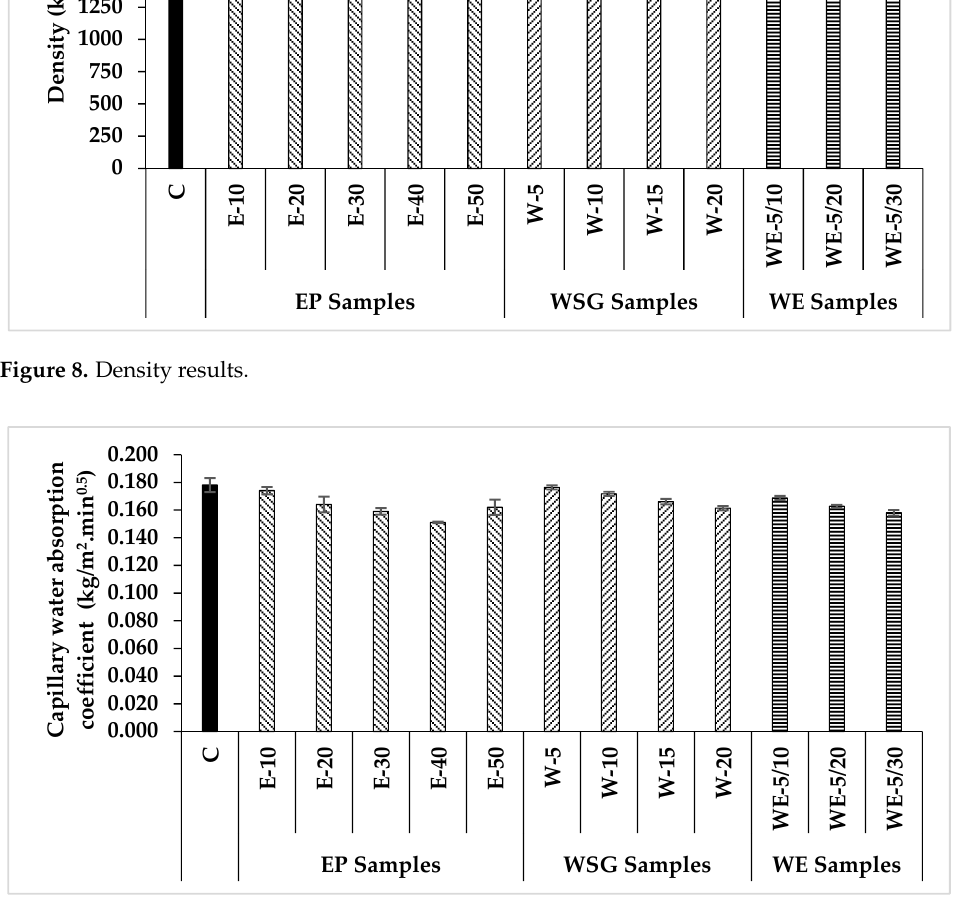
Figure 9. Capillary water absorption results.